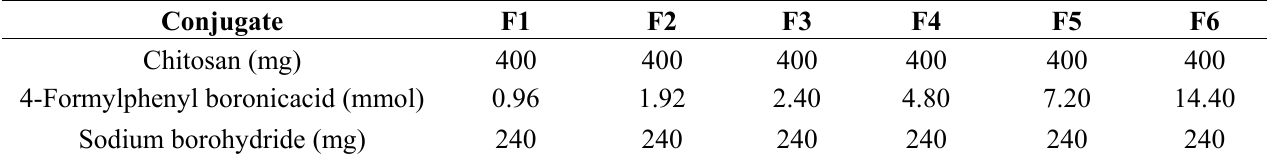
Table 1. Variation of 4-formylphenyl boronic acid used to formulate conjugates.